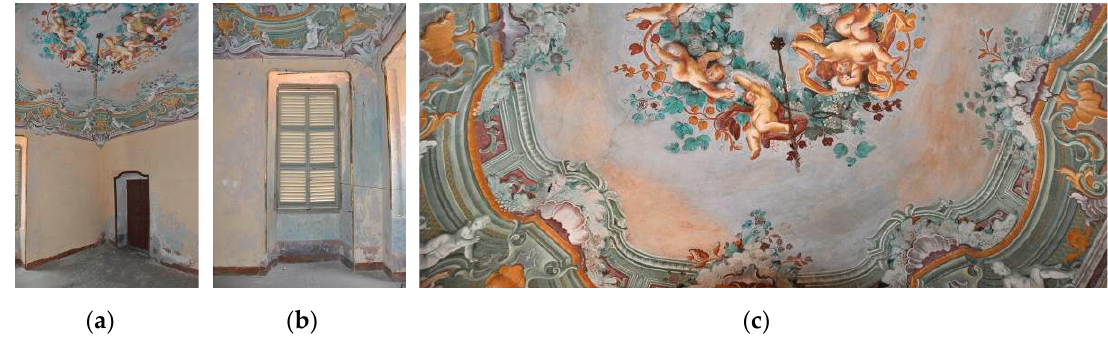
Figure 6. ( a ) First room with the entrance door, ( b ) window and ( c ) frescoed vault detail.